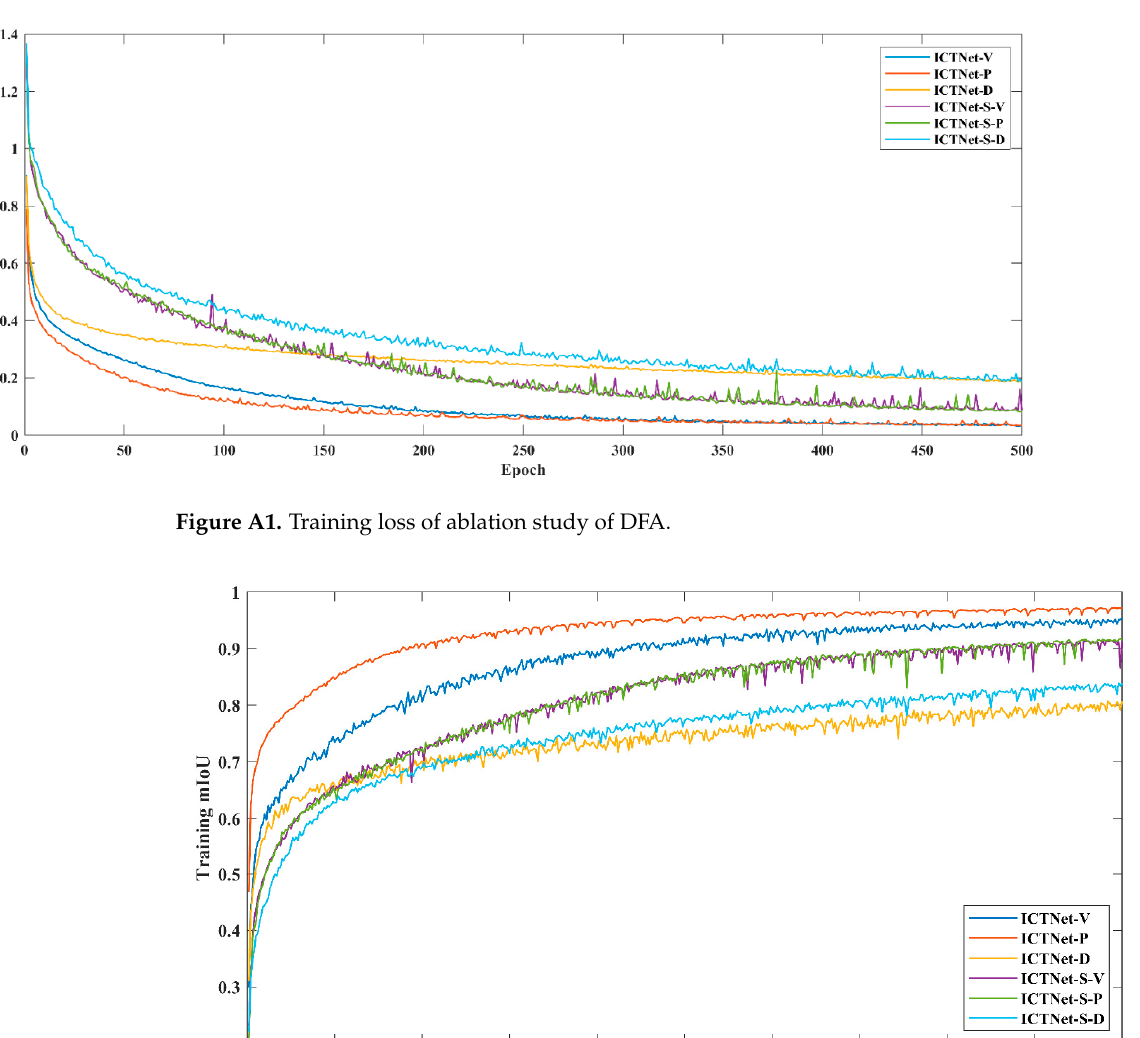
Table A1. Supplementary Details of ICTNet. The size and dimension of output with regard to the block are presented.